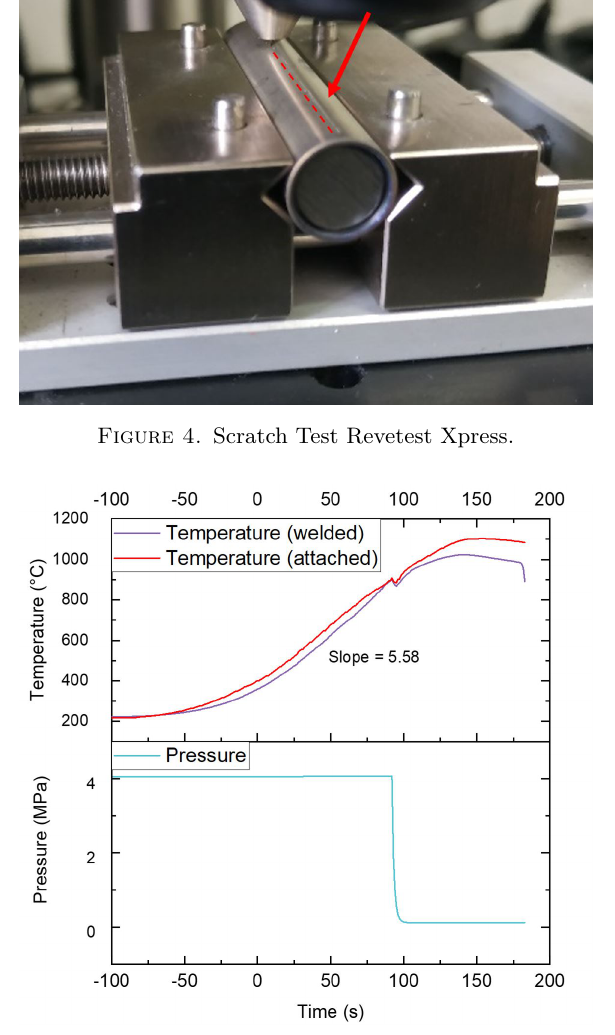
Figure 5. Time course of the burst